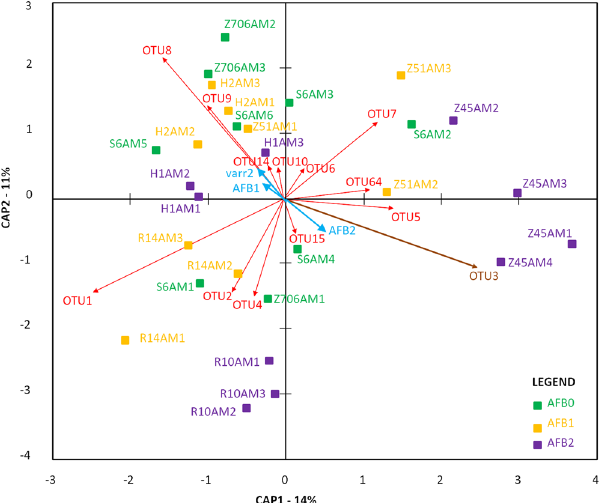
Figure 2. Triplot visualization of principal coordinates in the RDA of the Apis mellifera worker microbiome. The analysis was based on the total microbiome dataset and included varroosis and AFB environmental factors. A correlation triplot containing sample scores given by the weighted sums of OTUs was constructed. The first two axes explained 25% of the total variability in the dataset as indicated by the bracketed